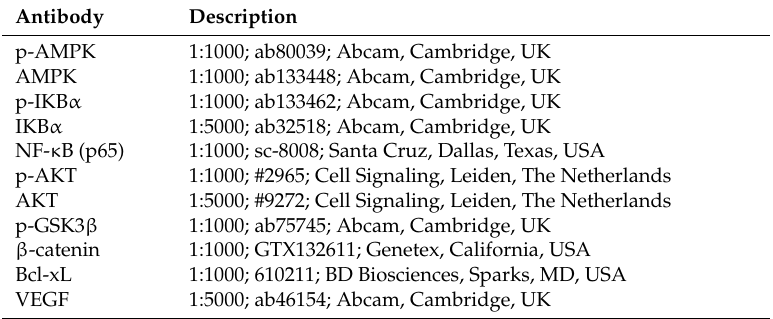
Table 2. Primary antibodies and specific dilutions used in Western Blot analysis. Antibody